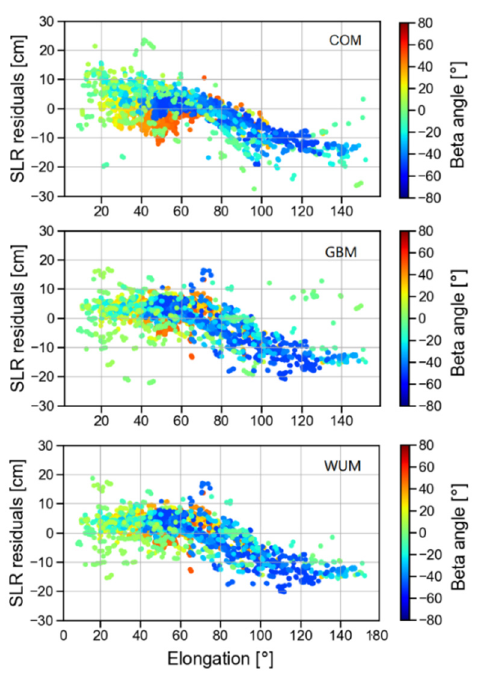
Figure 1. SLR residuals of C13 with distribution on the Sun elongation angle ( ϵ ) for CODE ( top ), GFZ ( middle ), and WHU ( bottom ). Table 1. Slope of the SLR residuals with respect to the Sun elongation angle ( (cid:101) ) for BDS-2 IGSO